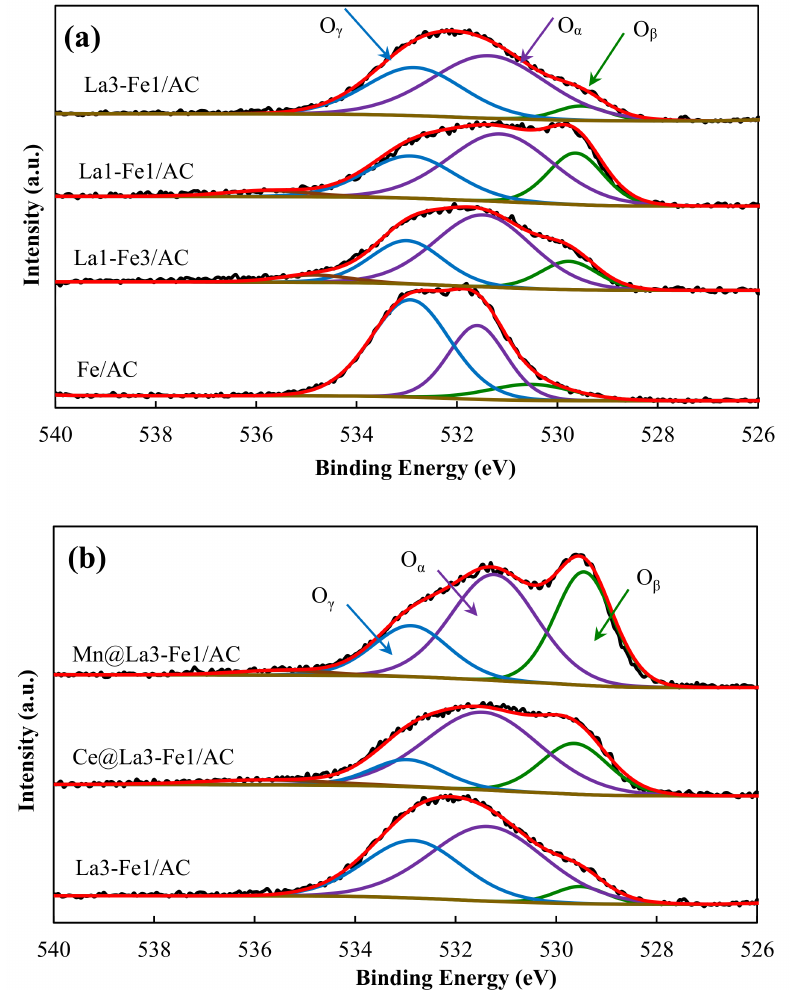
Figure 5. XPS spectrum of O 1s of the ( a ) La3-Fe1 / AC, La1-Fe1 / AC, La1-Fe3 / AC, and Fe /